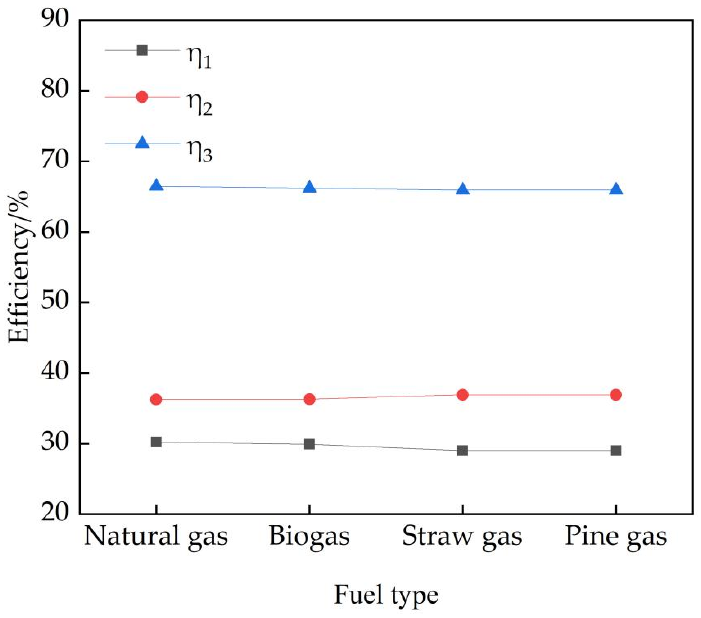
Figure 3. Efficiency diagram of recuperative cycle system.